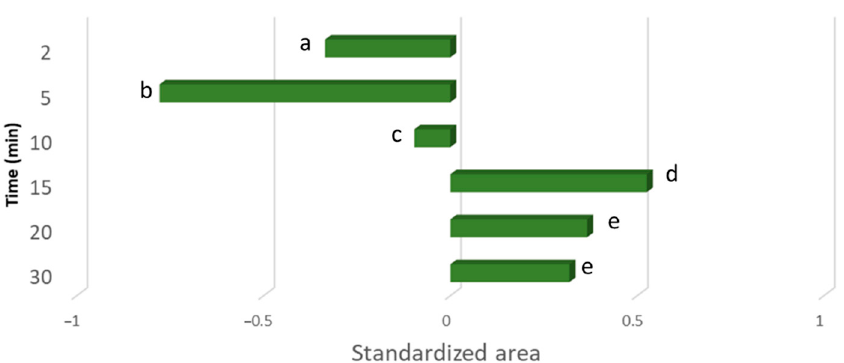
Figure 4. Effect of extraction time (2–30 min) on the mean ( n = 3) standardized recovery of phenolic compounds. Bars with different letters indicate significant differences ( p < 0.05).